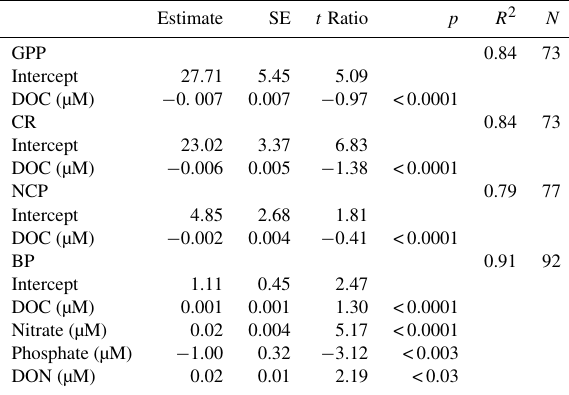
Table 3. Statistics for the fitted models for the different metabolic rates and the variables that explain its variability; to account for pseudo-replication, incubation day nested to season (i.e. experi- ment) was included as random factor. p was calculated comparing nested models. SE: standard error; N : number of observations. Estimate